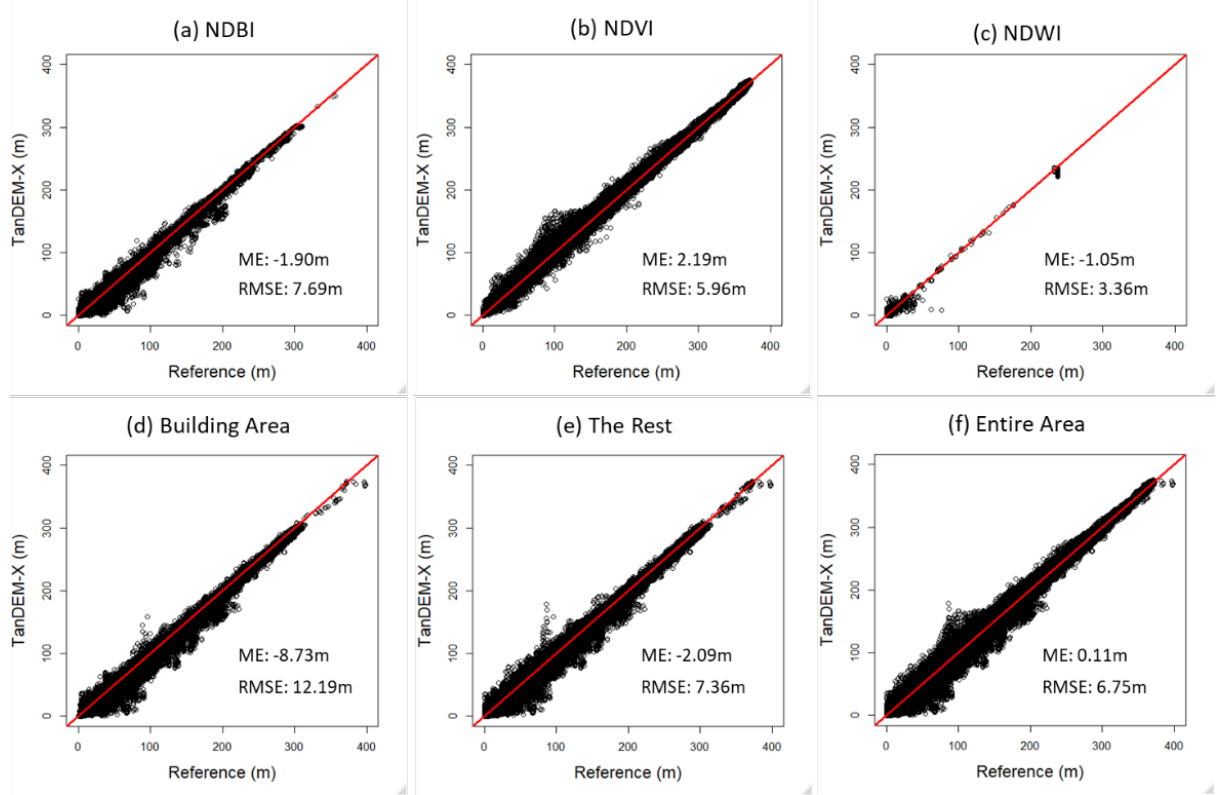
Figure 4. Scatterplots with ME and RMSE comparison of TanDEM-X over different land covers in Nice, France: ( a ) NDBI, ( b ) NDVI, ( c ) NDWI, ( d ) Building Area, ( e ) The Rest, ( f ) The Entire Area .